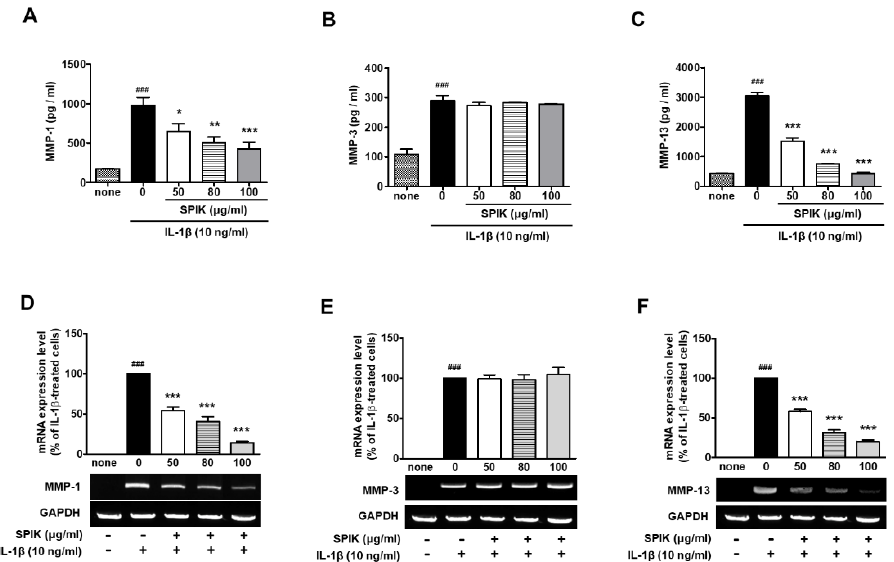
Figure 2. Effect of the 50% ethanolic extract of Manchurian spikenard on the IL- 1β -stimulated protein and mRNA expression levels of MMP-1 ( A , D ), MMP-3 ( B , E ) and MMP-13 ( C , F ) in human OA chondrocytes. SPIK, Manchurian spikenard extract; MMP, matrix metalloproteinase; GAPDH, glyceraldehyde 3-phosphate dehydrogenase. ### p < 0.001 vs. non-treated naïve cells (none); * p < 0.01, ** p < 0.005 and *** p < 0.001 vs. the IL- 1β -treated cells without treatments.